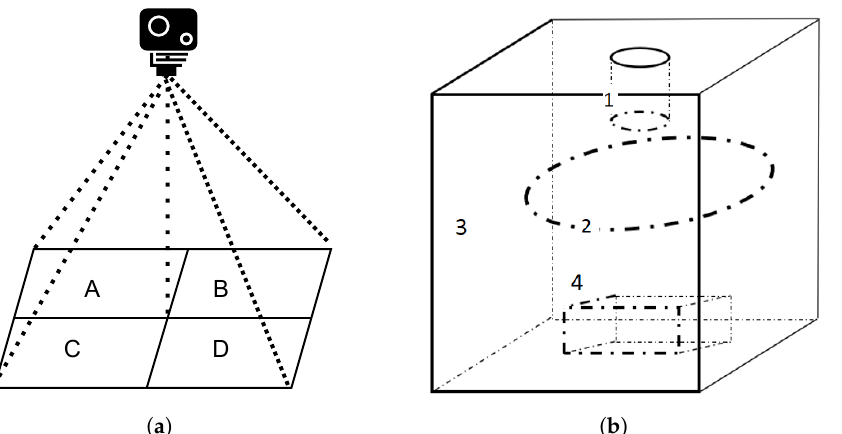
Figure 3. ( a ) Shooting configuration. ( b ) Diagram of a dimmable test platform with an industrial camera at 1 , a ring dimmable light at 2 , a placing platform at 3 , and a closed black box (i.e., 4 ).